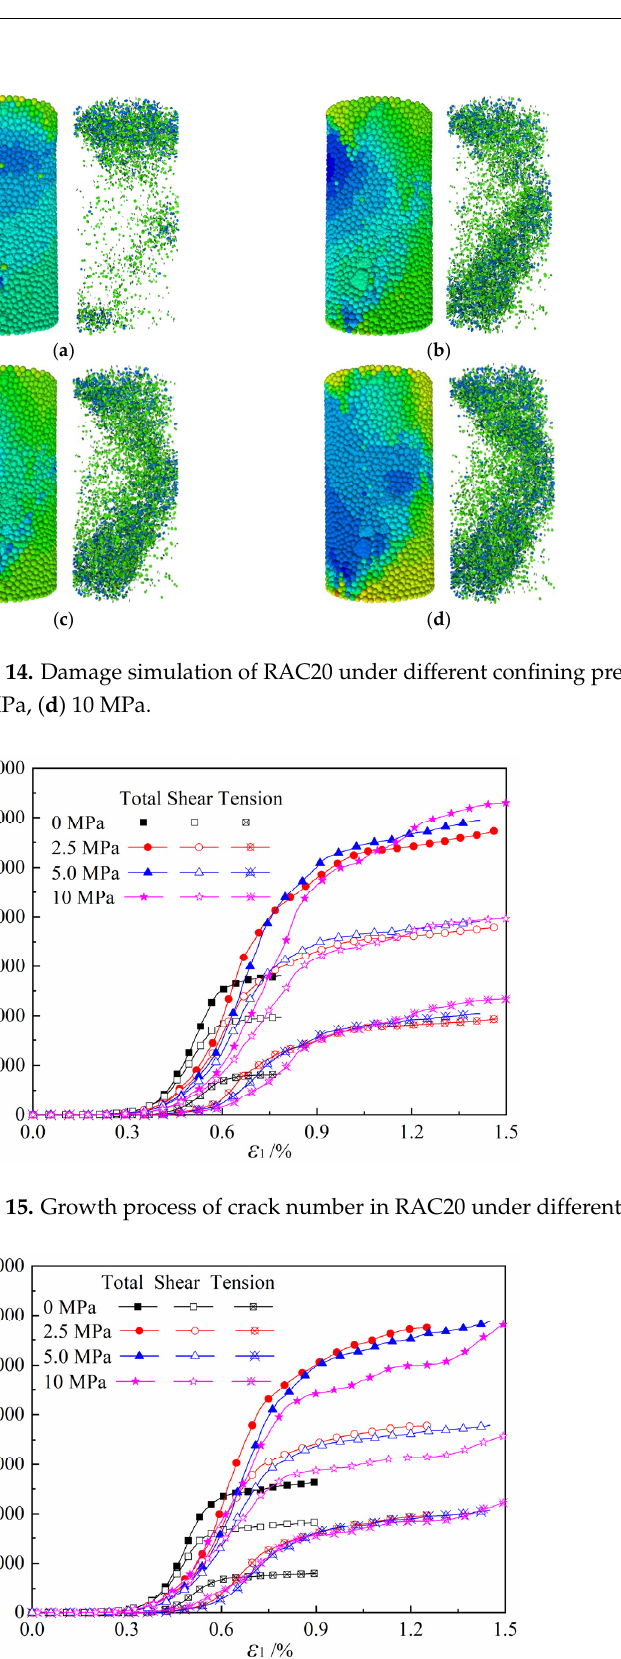
Figure 16. Growth process of crack number in RAC6012 under different confining pressures.